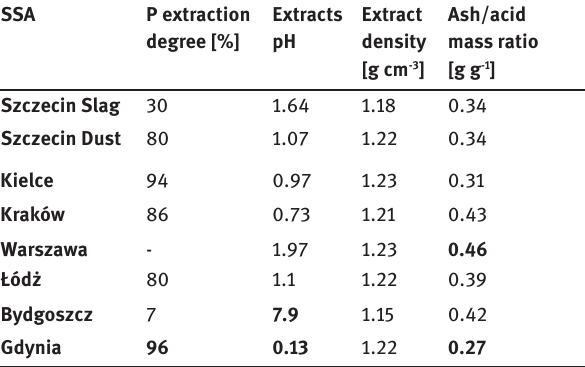
Table 3: Extraction characteristic: P extraction degree, pH and density of extracts and ash to acid solution mass ratio used during leaching process.